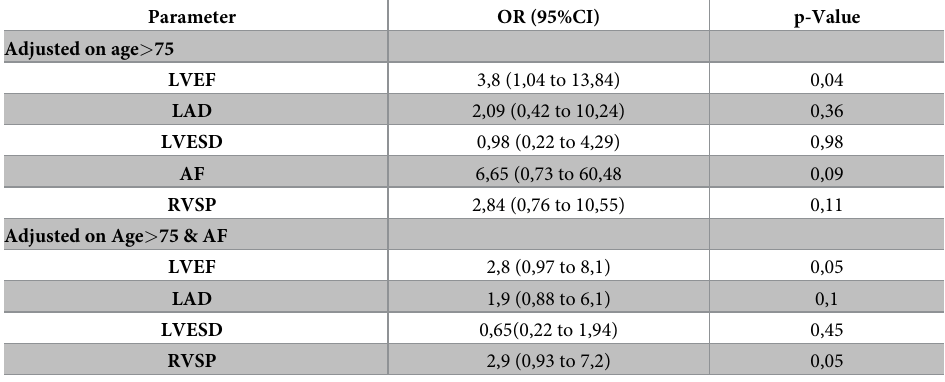
Table 5. The adjusted multivariate regression analysis: Only age > 75 and age > 75 & presence of atrial fibrillation. Parameter OR (95%CI) p-Value Adjusted on age > 75 LVEF 3,8 (1,04 to 13,84) 0,04 LAD 2,09 (0,42 to 10,24) 0,36 LVESD 0,98 (0,22 to 4,29) 0,98 AF 6,65 (0,73 to 60,48 0,09 RVSP 2,84 (0,76 to 10,55) 0,11 Adjusted on Age > 75 & AF LVEF 2,8 (0,97 to 8,1) 0,05 LAD 1,9 (0,88 to 6,1) 0,1 LVESD 0,65(0,22 to 1,94) 0,45 RVSP 2,9 (0,93 to 7,2) 0,05 AF: Atrial fibrillation, LV: Left ventricle, EF: Ejection fraction, ESD: endsystolic diameter, LAD: left atrial diameter, RVSP: Right ventricle systolic